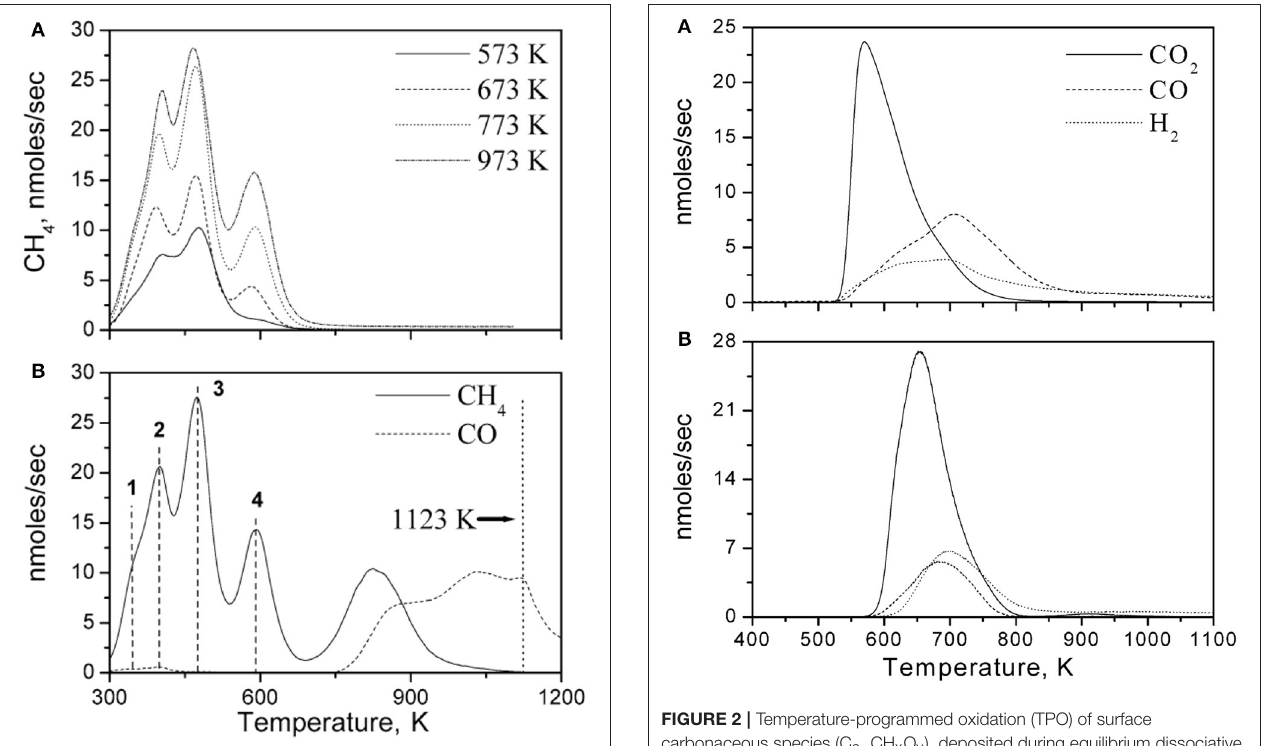
FIGURE 1 | Spectra of surface carbon under 2.5% H 2 /Ar flow, deposited during equilibrium dissociative adsorption of CH 4 (A) at different temperatures with initial amount of CH 4 17.7 µ mol, and (B) at 773K with initial amount of CH 4 59.6 µ mol. The numbers 1, 2, 3, and 4 correspond to the various CH x species (1:CH 4 ….4:CH). Total flow rate 167 cc STP/min, ramp rate: 20 K/min. Catalyst Ni(Au 0.2%at)/YSZ. Reprinted with permission from Triantafyllopoulos and Neophytides (2006) .